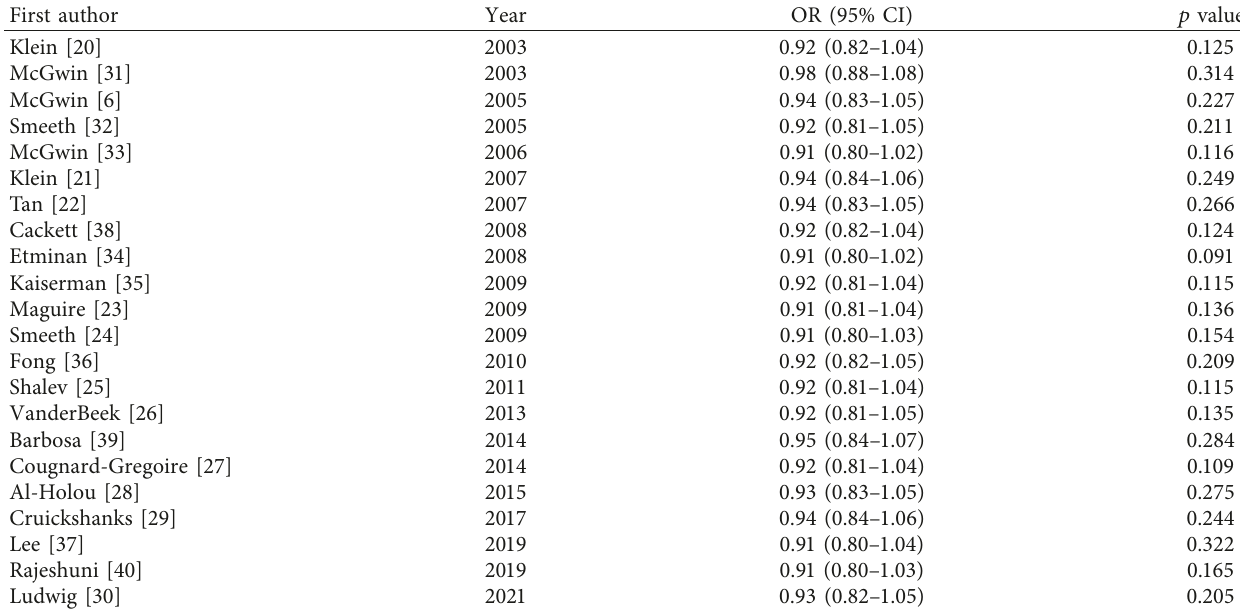
100.00LudwigRajeshuniLeeCruickshanksAI-HolouCougnard-GregoireBarbosaVanderBeekShalevFongSmeethMaguireKaisermanEtminanCackettTanKleinMcGwinSmeethMcGwinKlein Figure 2: The forest plot of the relationship between statin consumption and risk of developing age-related macular degeneration. Table 3: Sensitivity analysis for the assessment of the relationship between statin consumption and risk of developing